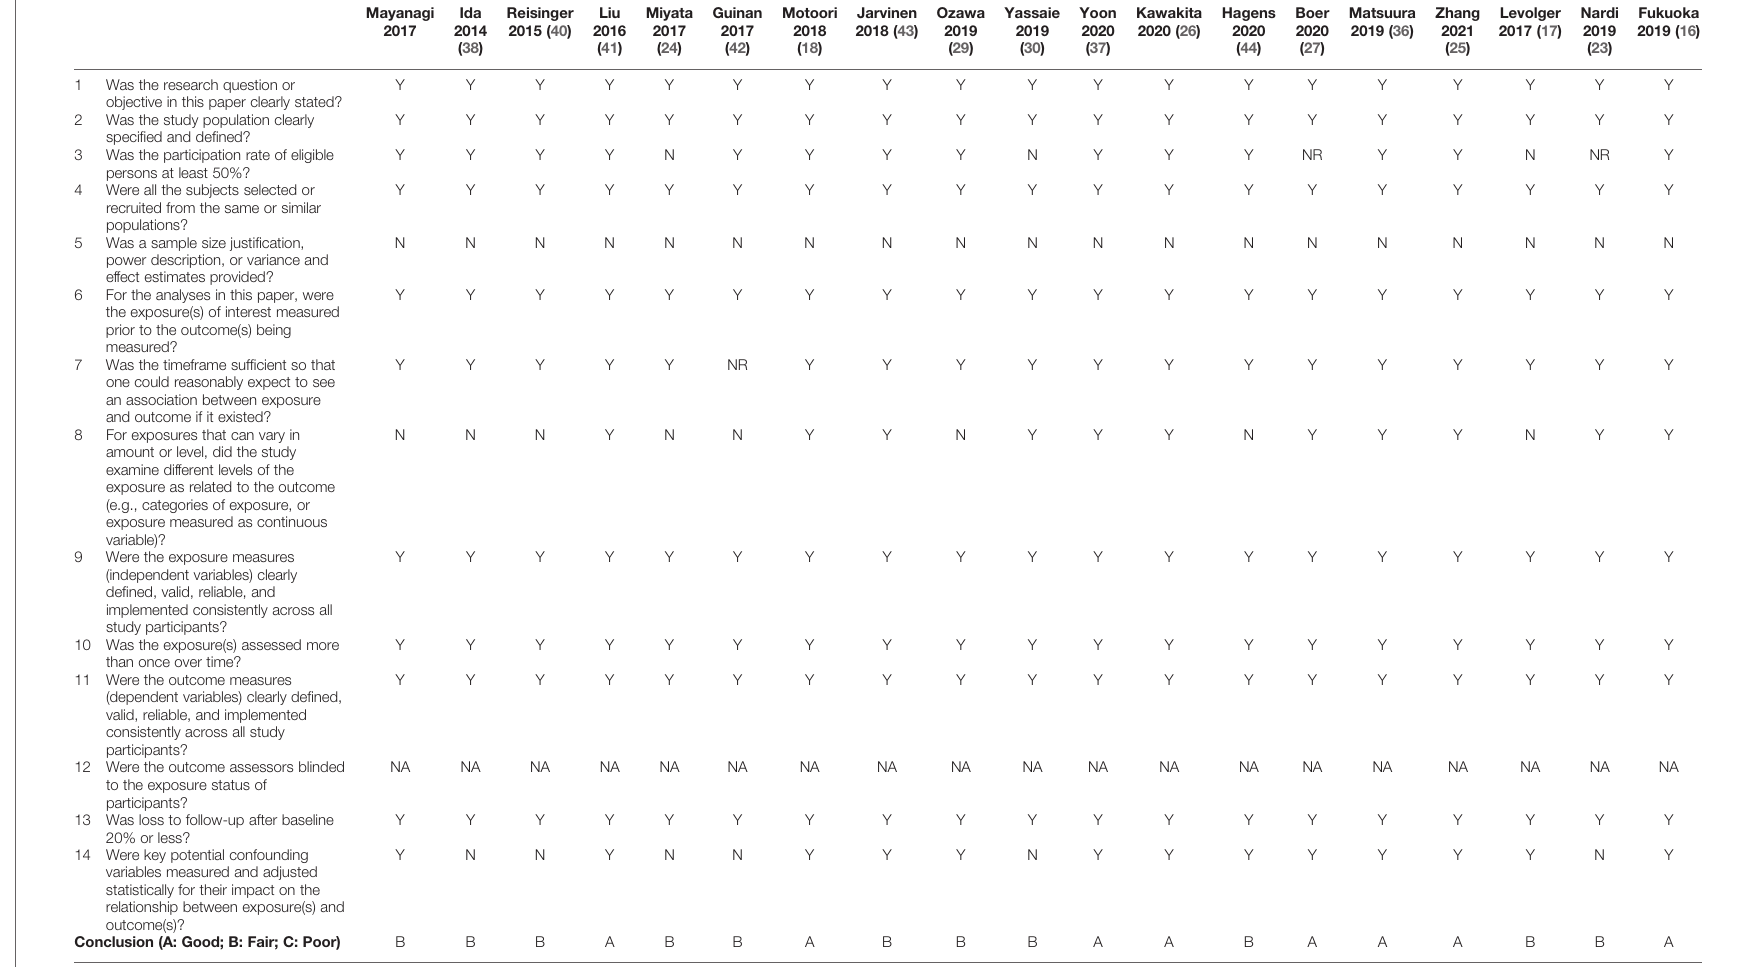
TABLE 4 | Quality assessment for included studies based on NIH Quality Assessment Tool for Observational Cohort and Cross-Sectional Studies (n =